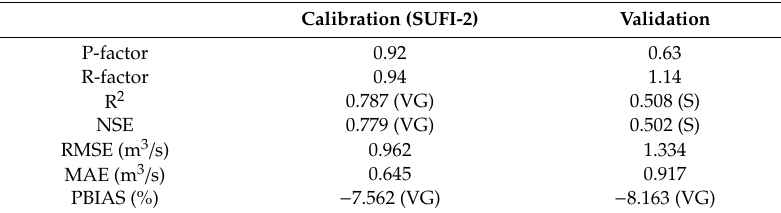
Table 7. The results of the calibration and validation.